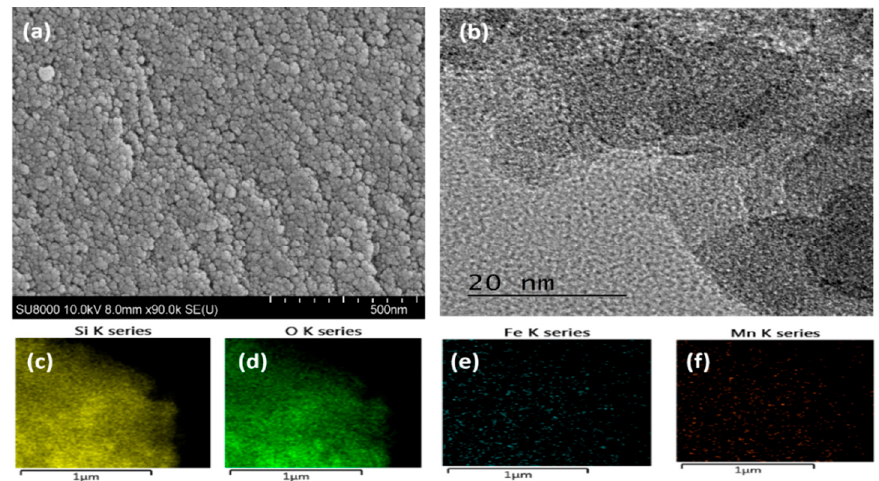
Figure 3. ( a ) SEM, ( b ) TEM, ( c – f ) elemental spectrum of Fe 2 O 3 -Mn 2 O 3 /SiO 2 .